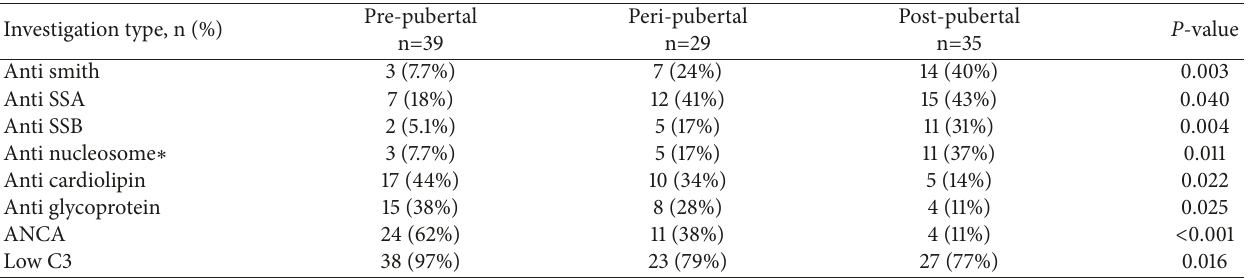
Table 3: Investigations of systemic lups erythematosus (SLE) patients according to age at onset of disease.